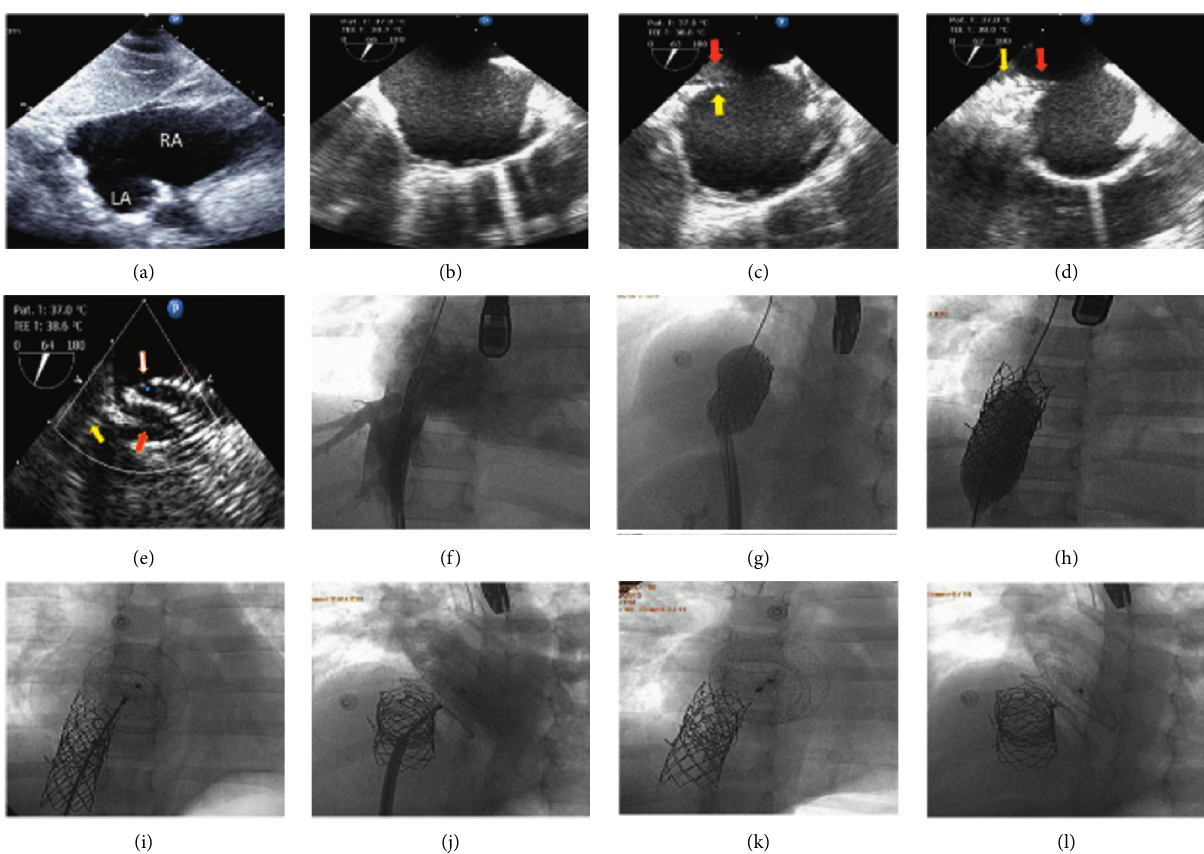
Figure 3: (a) Transthoracic echocardiogram, subcostal bicaval view demonstrates a large secundum ASD with an absent inferior rim. (b) TEE in long axis bicaval view shows large secundum ASD with absent inferior rim with right sided volume overload. (c, d) TEE in long axis view demonstrates the struts of the distal part of the inflated CP stent (yellow arrow) at the entrance of the IVC creating a new inferior rim (red arrow). (e) TEE imaging in a modified long axis view demonstrates struts of the inflated uncovered CP stent (yellow arrow) at the entrance of the IVC creating a new inferior rim (red arrow) which has been captured by two discs of the ASO (white arrow). (f) Cine angiogram of the IVC in frontal view demonstrates the uncovered CP stent mounted over the Z -med balloon size (25 × 40mm) at the entrance of the IVC under the guidance of the TEE for proper position of the stent. (g) Cine imaging of the heart in four chamber view demonstrates the inflation of the uncovered CP stent, 8 zig, 45mm, using Z -med balloon size (25 × 40mm) at the entrance of the IVC into the RA under the guidance of the TEE. (h) Cine imaging of the heart in frontal view demonstrates the inflation of the second CP-stent 8 zig, 39mm, overlapping with previous stent for proper fixation. (i) Cine imaging of the heart in the frontal projection demonstrates the proper deployment of the Amplatzer septal occluder size 34mm before release. (j) RA angiogram in four chamber view through cook sheath 14F demonstrates the deployed septal occluder which was well aligned with IAS. (k) Cine imaging of the heart in aneteroposterior projection demonstrates both the two overlapping uncovered CP stents in the IVC with the proper position of the atrial septal occluder. (l) Cine imaging of the heart in four chamber projection demonstrates two overlapping uncovered CP-stents and the device which is well aligned with IAS under the guidance of the TEE, the device is not anchored the CP stent at